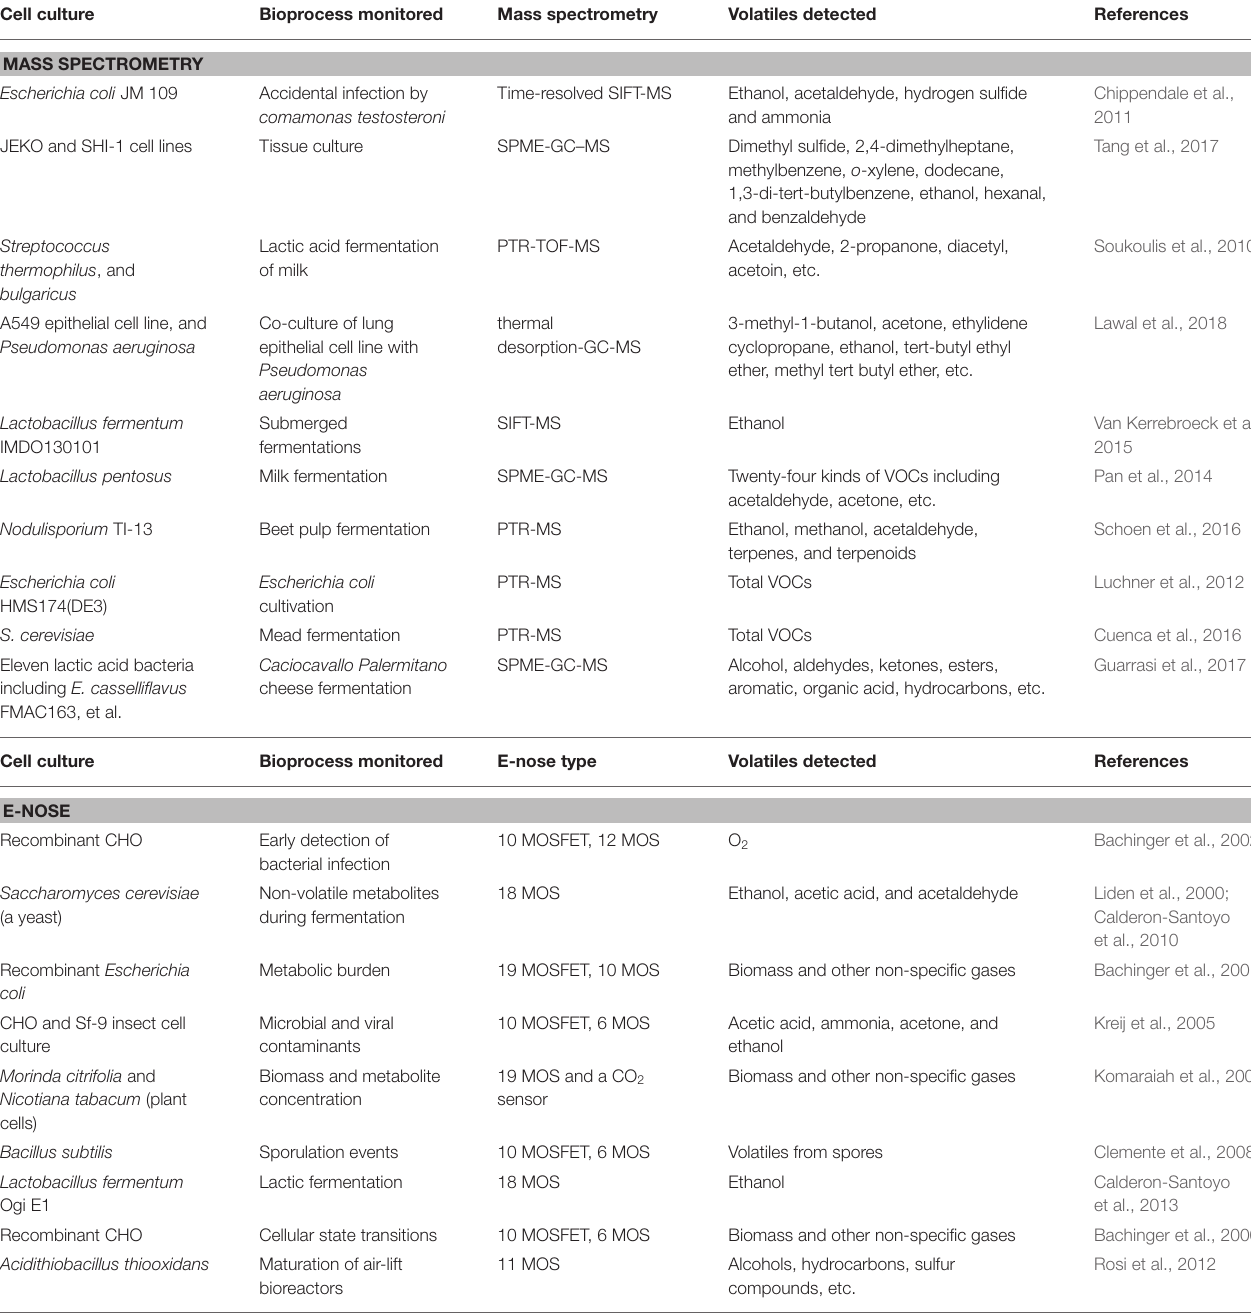
TABLE 1 | List of techniques of mass spectrometry or electronic noses employed for off-gas monitoring of specific cell